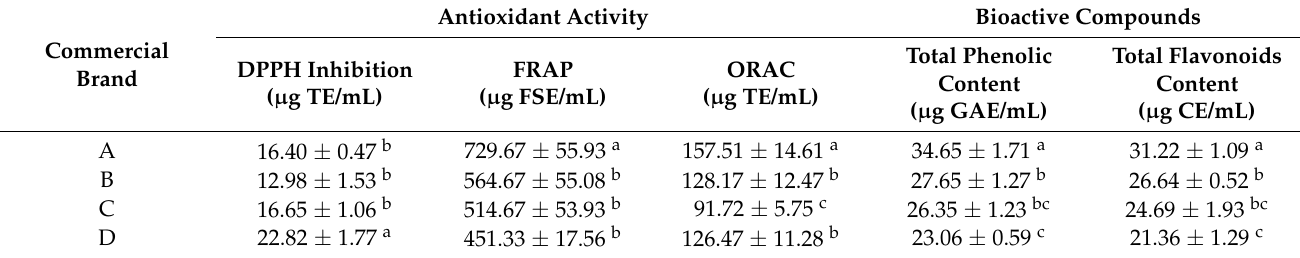
Table 2. Antioxidant activity, total phenolics and flavonoids of rosemary infusions from different